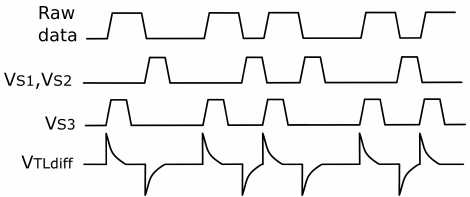
Figure 6. Example of transmission in the 3-switches TX